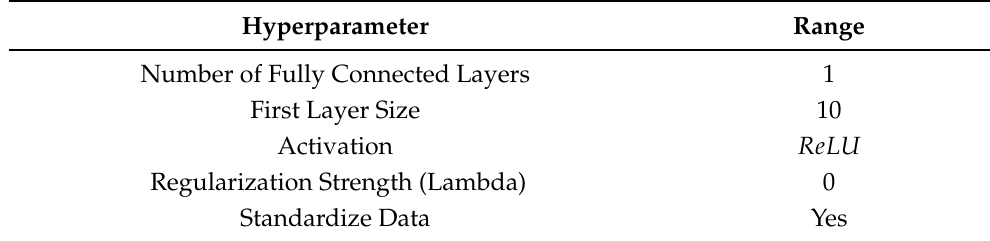
Table 5. Optimized hyperparameter configuration.